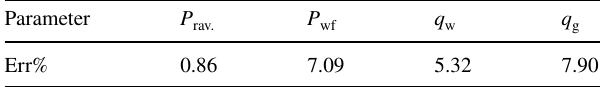
Table 13 Error percent of calculated parameters of case#1 by FDGRS simulator